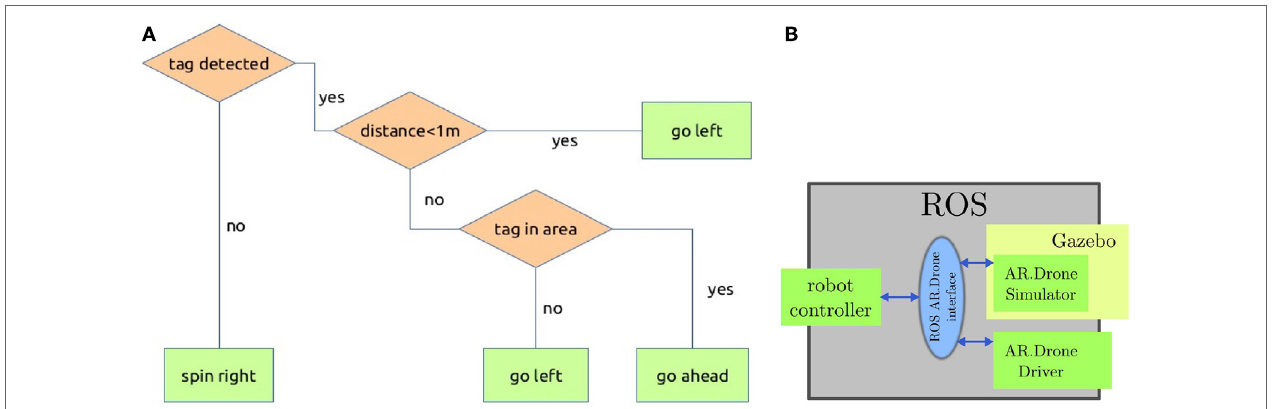
FigUre 4 | (a) Weaving behavior of a self-organizing ARC Quad-rotor. It circles clock-wise around a pole, tightening its thread around suspension lines tagged with directionally oriented markers. © 2014 IEEE. Reprinted, with permission, from von Mammen et al. (2014). (B) Interwoven Simulation Modules. The Robot Operating System integrates various software components to simulate quad-rotor swarms. In particular, we control the robot using a common ROS-based instruction set that is understood by both the Gazebo simulation software and its quad-rotor simulation plug-in as well as a ROS driver that steers the actual quad-rotor hardware. © von Mammen et al. (2016) CC BY-NC-SA